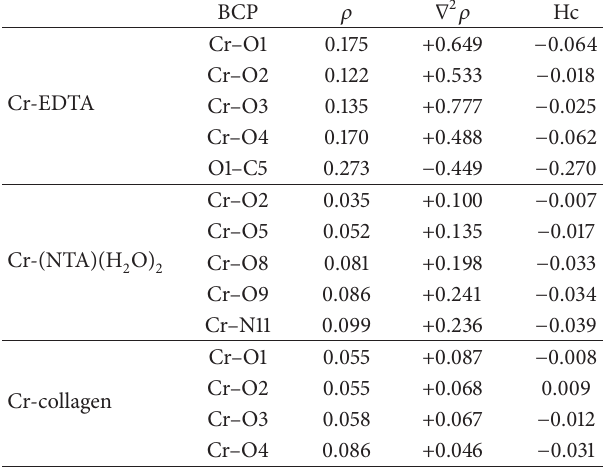
Table 3: QTAIM parameters obtained by the main interatomic interactions in the isomer (B) of the Cr-EDTA complex, the Cr- O) , and Cr-collagen complex in a.u. NTA(H 2 2